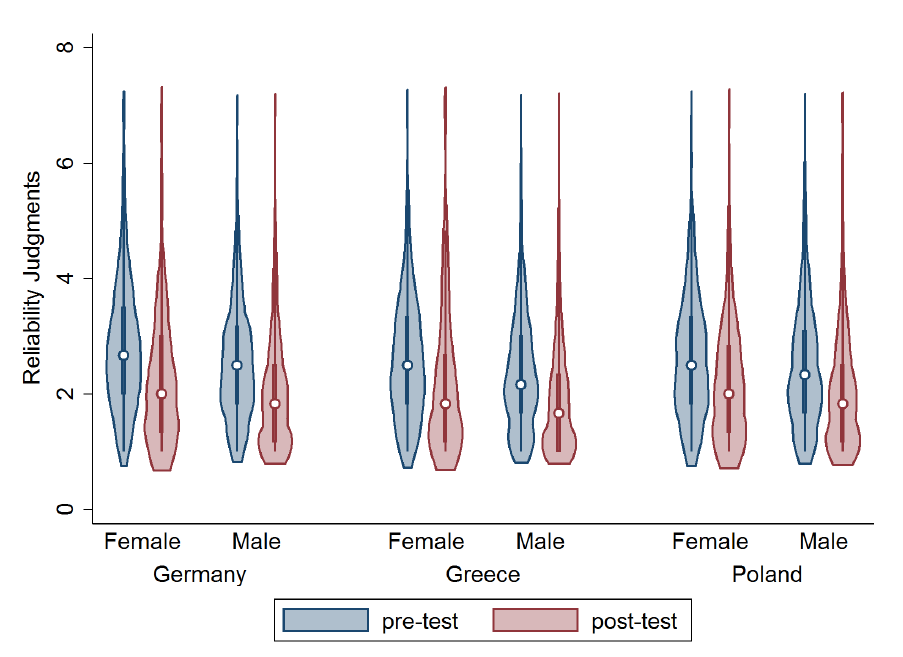
Figure 2. Violin plots for the German, Greek, and Polish versions of the game (pre-and-post-test), by gender. The violin shape represents the distribution of the data and the point estimate is the median (with boxplot). All pre-post differences within each country (by gender) are statistically significant at the p < 0.001